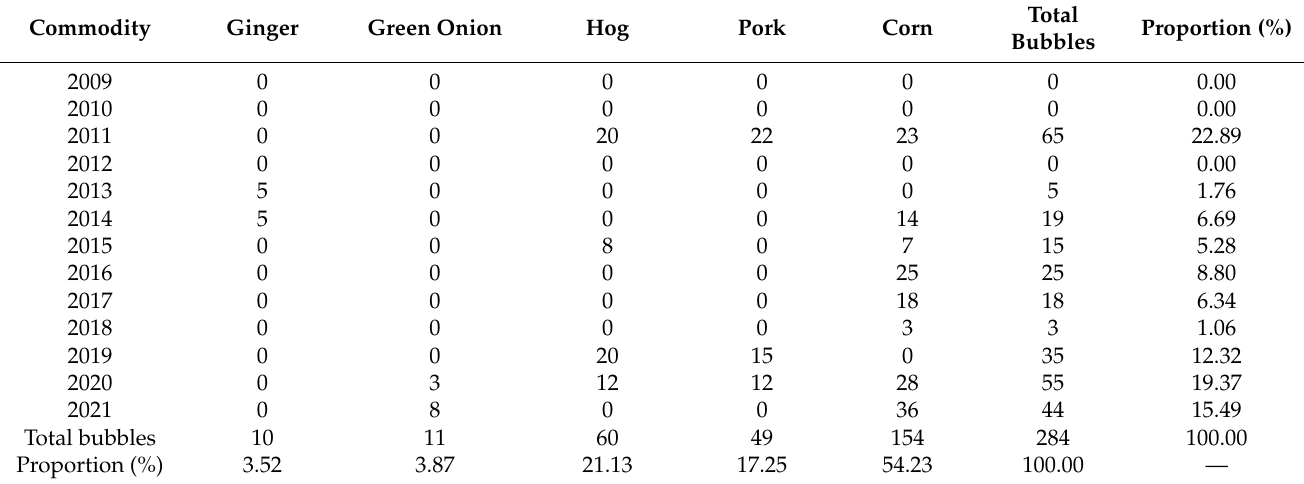
Table 5. Temporal distribution of agricultural commodity price